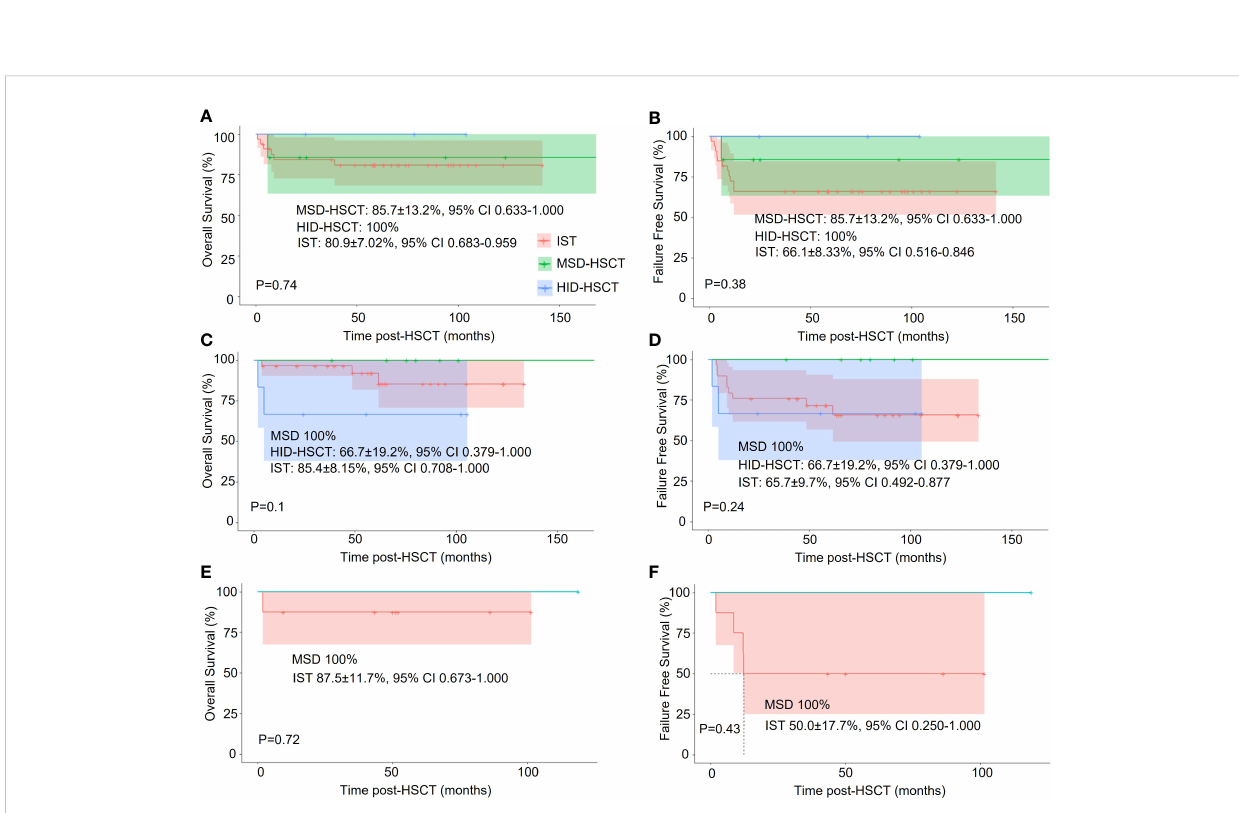
FIGURE 4 Strati fi ed analysis of the effect of different treatments on OS and FFS in patients of different ages. (A, C, E) . One-year Overall survival (OS) among patients <20y, 20~40y, and >40y, respectively; (B, D, F) Failure-free-survival (FFS) among patients <20y, 20~40y, and >40y,